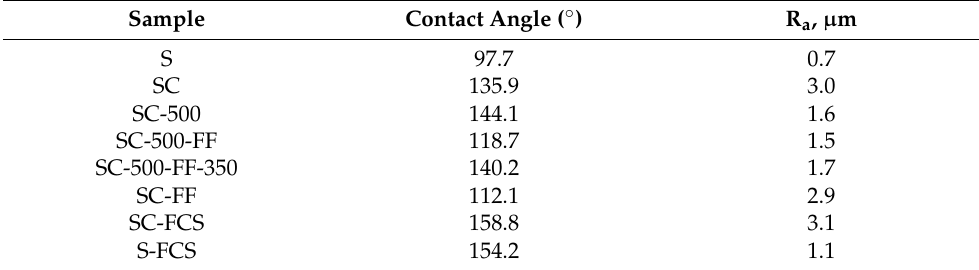
Table 6. Wettability and roughness parameters of the specimens with different types of